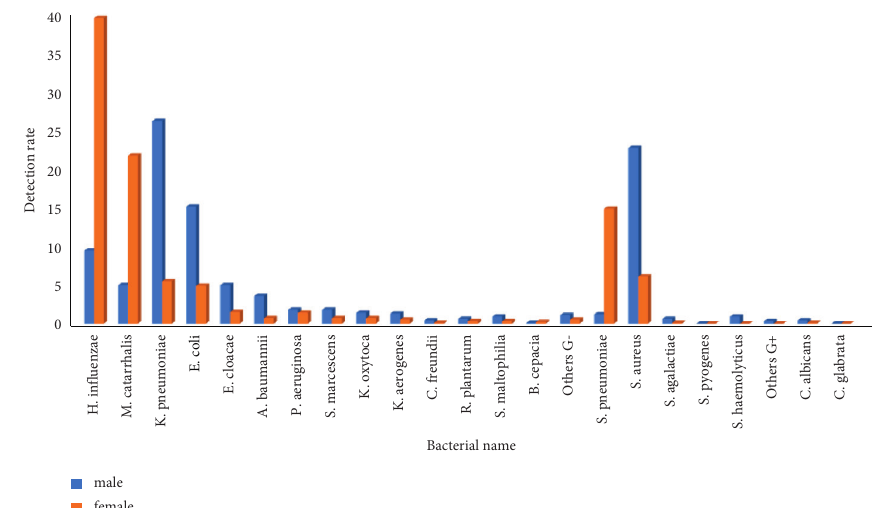
Figure 4: Detection rate of lower respiratory tract pathogens by gender in infant group (0-1year old) from 2011 to 2020 (%).